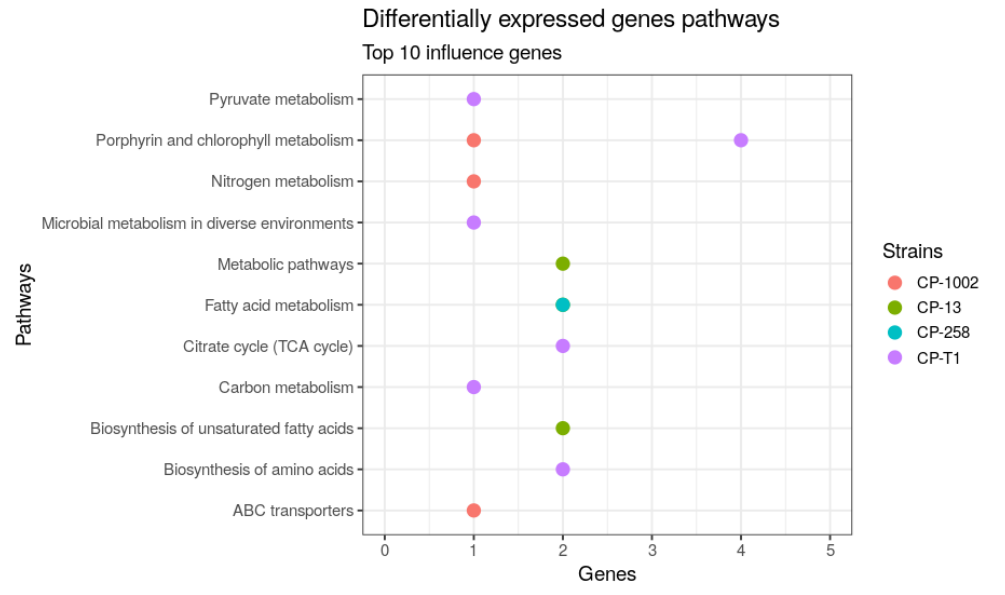
Figure 3. Pathways involved with the top 10 genes identified in the differential expression network in Cp-258 and